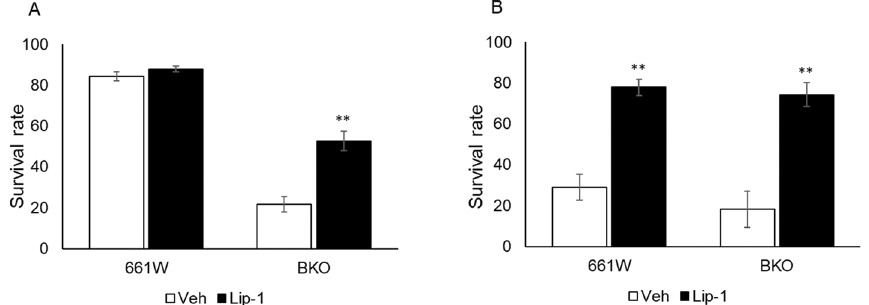
Figure 5. Inhibition of ferroptosis pathway by Lip1 increased cell survival from H 2 O 2 -induced cell death. (A) Treatment of Lip1 increased cell viability by approximately 30% in BKO cells at 26.5 h after medium exchange. (B) Lip1 treatment significantly increased cell viability in both cell types from H 2 O 2 -induced cell death at 38.5 h after medium exchange (two-way ANOVA followed by Tukey multiple comparison test, n = 6, ** p < 0.01 control vs.